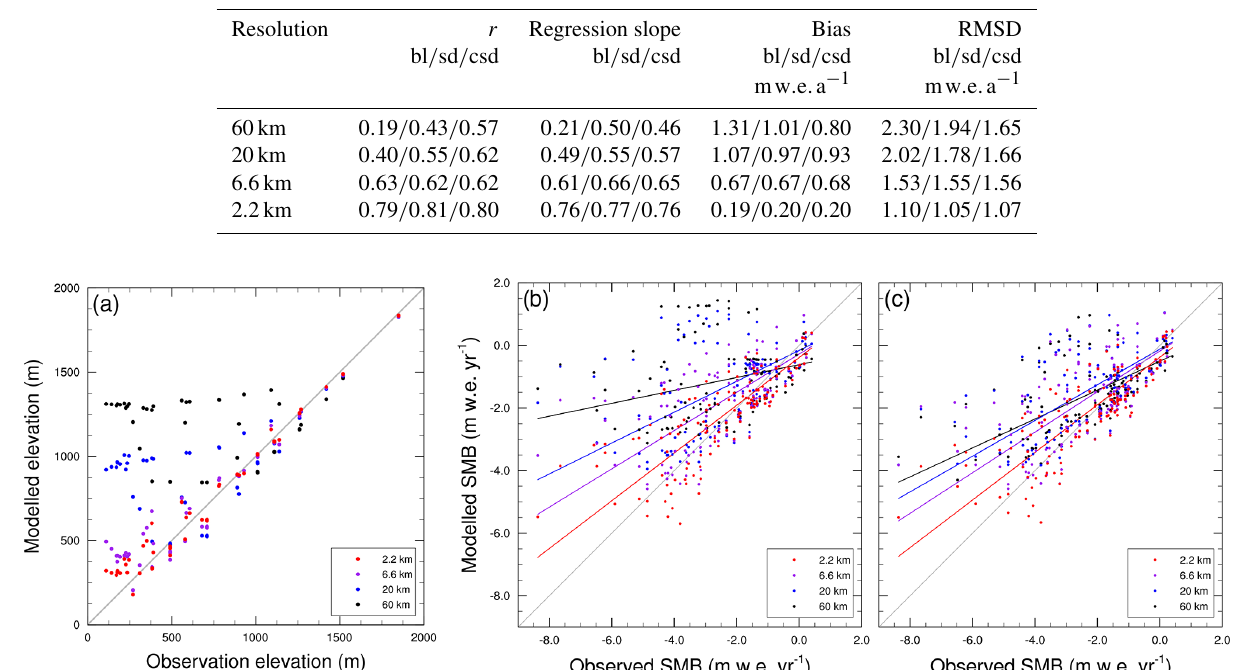
Figure 6. Estimated versus (a) true observational site elevation and (b, c) observed SMB for all four model resolutions using (a, b) bilinear interpolation and (c) component-wise statistical downscaling. Fits are derived using orthogonal regressions and the 1-to-1 line is drawn in grey for